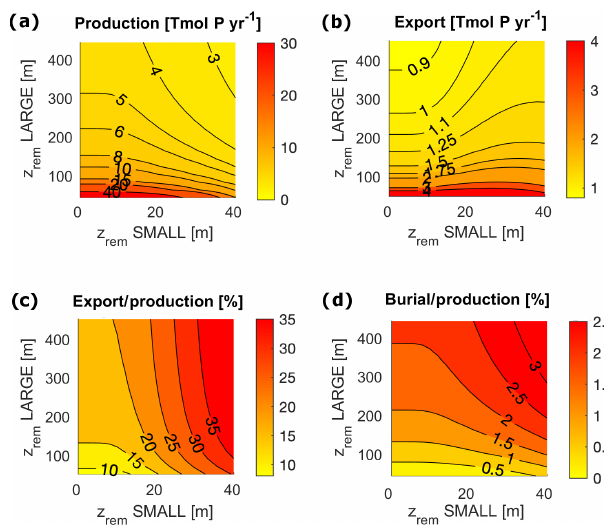
Figure 7. Biological pump fluxes in P units for the entire ocean for varying z remS and z remL in the following cases: (a) P org surface production; (b) P org export through the euphotic layer depth; (c) export/production, i.e. export to production ratio; and (d) burial to production